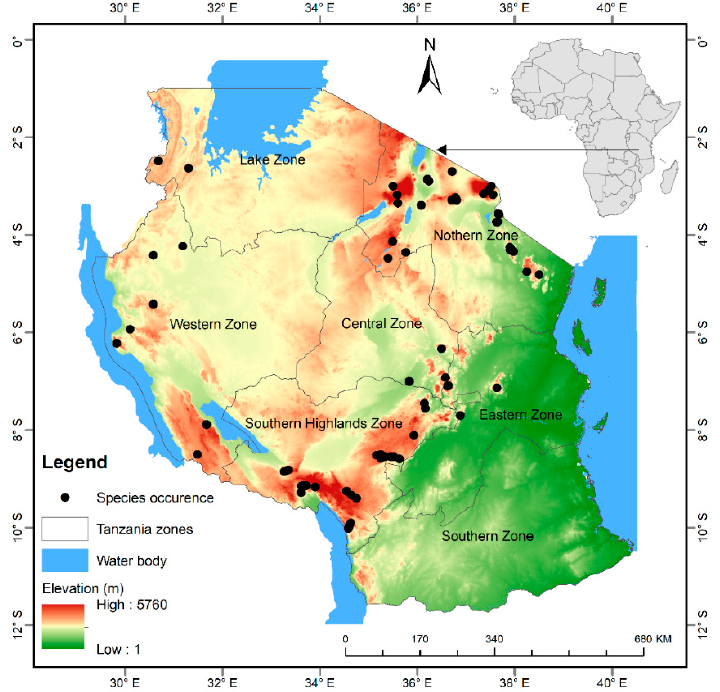
Figure 1. Location map of the study area Tanzania. Black points show species occurrence. Note that the data for P. africana is superimposed on top of elevation layer.